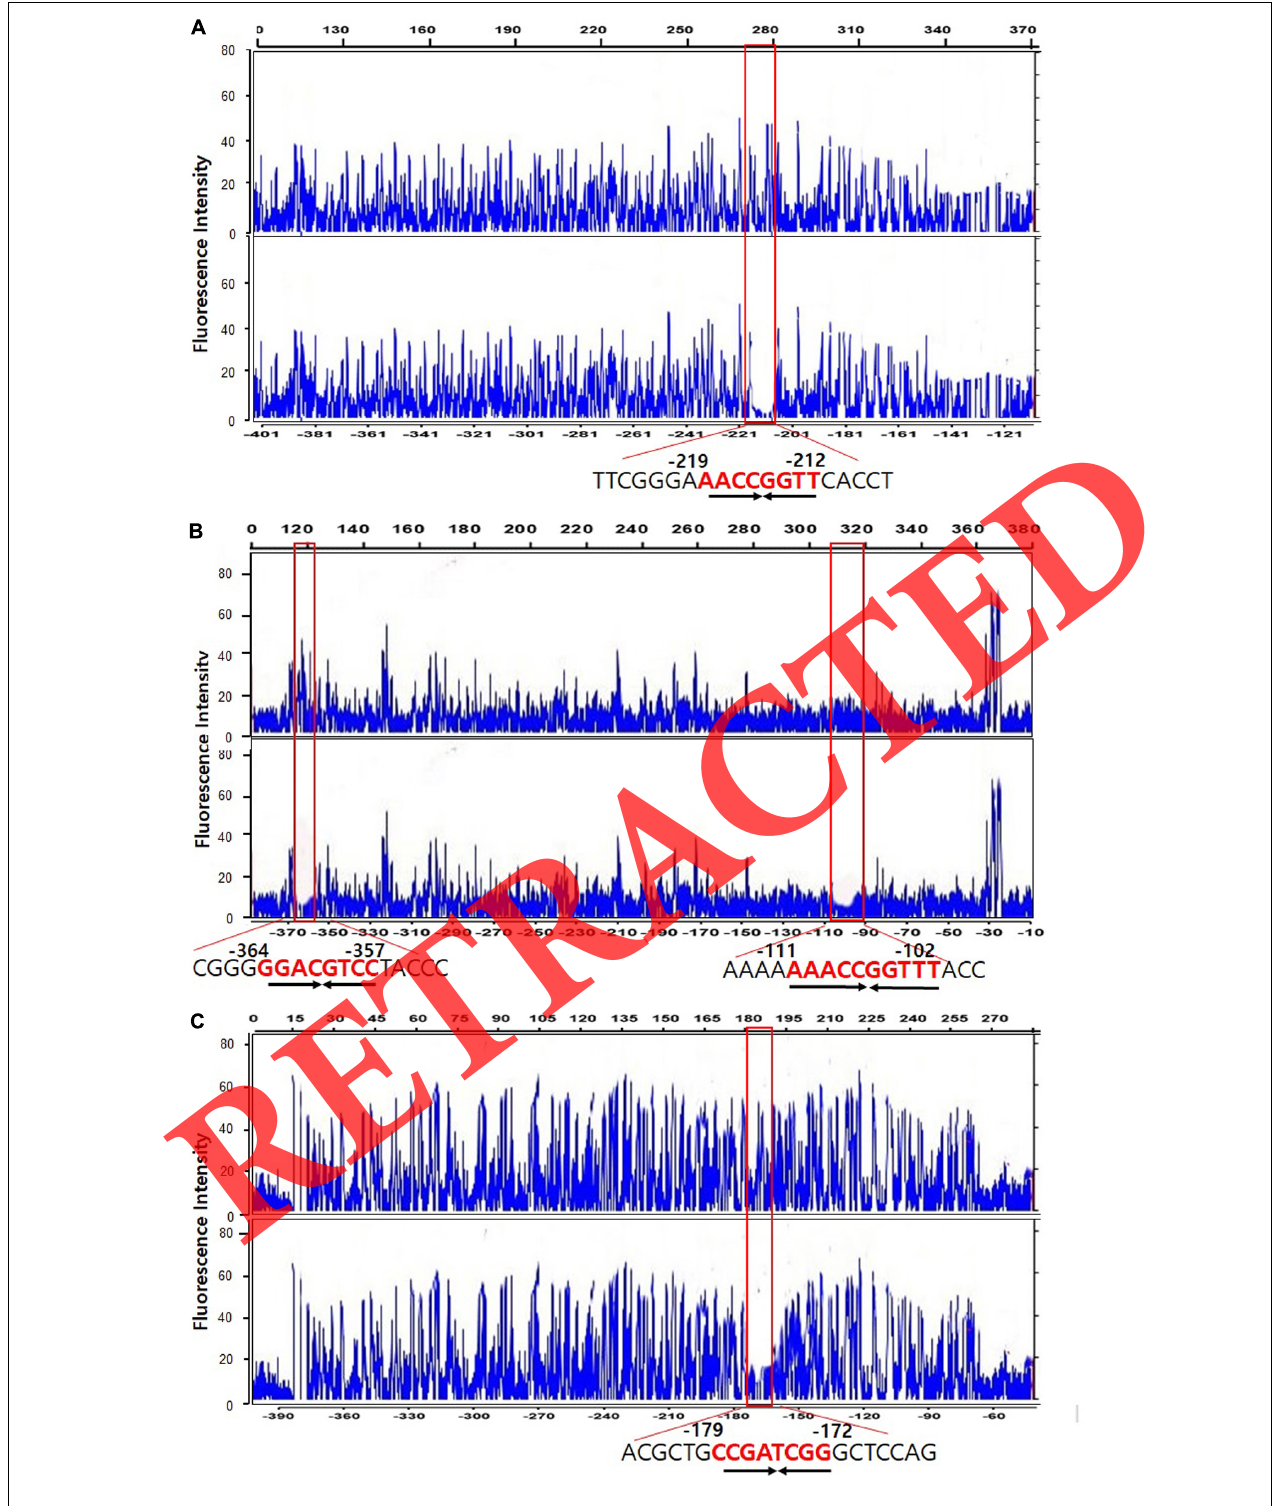
FIGURE 5 | DNase 1 footprinting assays for the identification of DNA motif bound by DagR. Electropherograms showing the protection pattern of each promoter of fluorescent dye-labeled upstream region of dagA (A) , dagB (B) , and dagC (C) after digestion with DNase 1 following incubation in the absence (up) or presence (bottom) of DagR protein. The y -axis gives fluorescence intensity (i.e., fragment abundance), while the x -axis (upper) gives elution position, which is proportional to size. At the bottom is a scale that gives nucleotide position relative to the each gene. The protected regions are indicated with red box, and the palindrome sequences (DagR-binding sites) are shown below. The numbers refer to the distance from translation start site of the each gene.